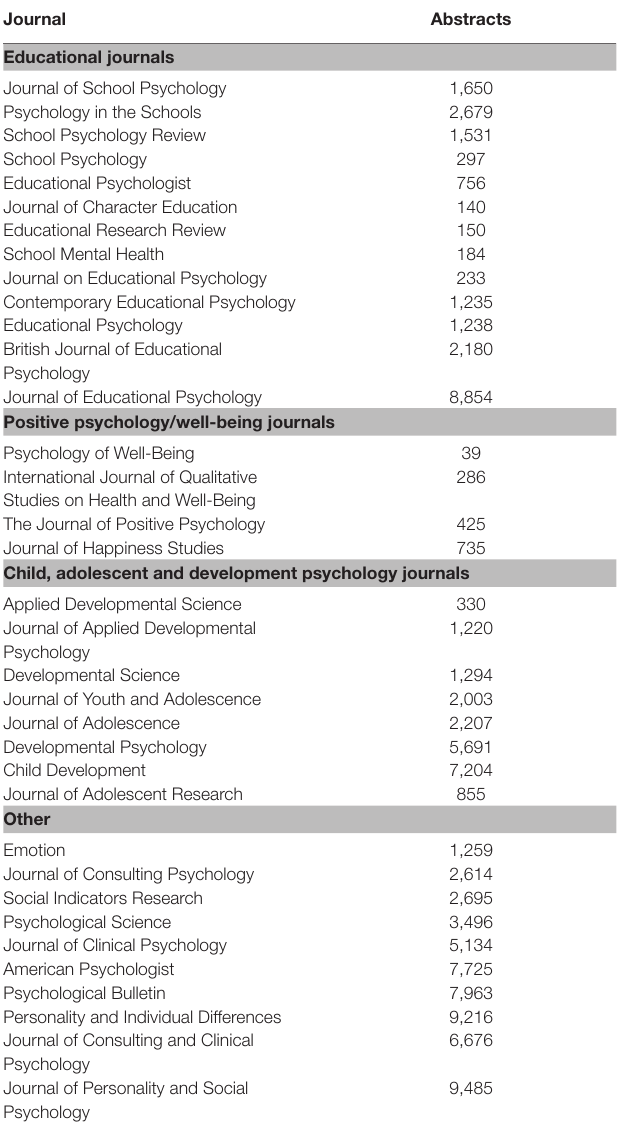
TABLE 2 | Journals selected to form the database for current review